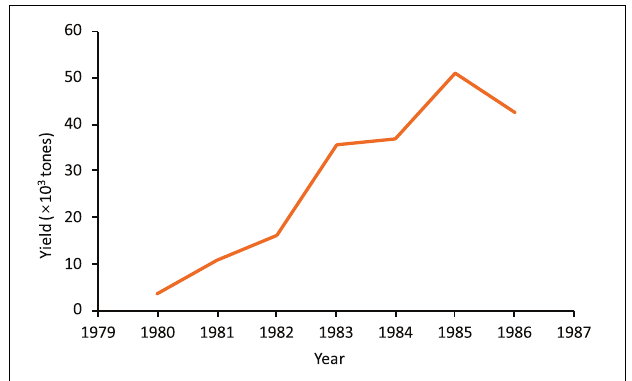
FIGURE 4 | Yield of miter squid in the Shantou-Taiwan Bank fishing ground by Nan’ao County during 1980–1986 (Li and Wu, 1988). The location of Nan’ao County is indicated in Figure 1